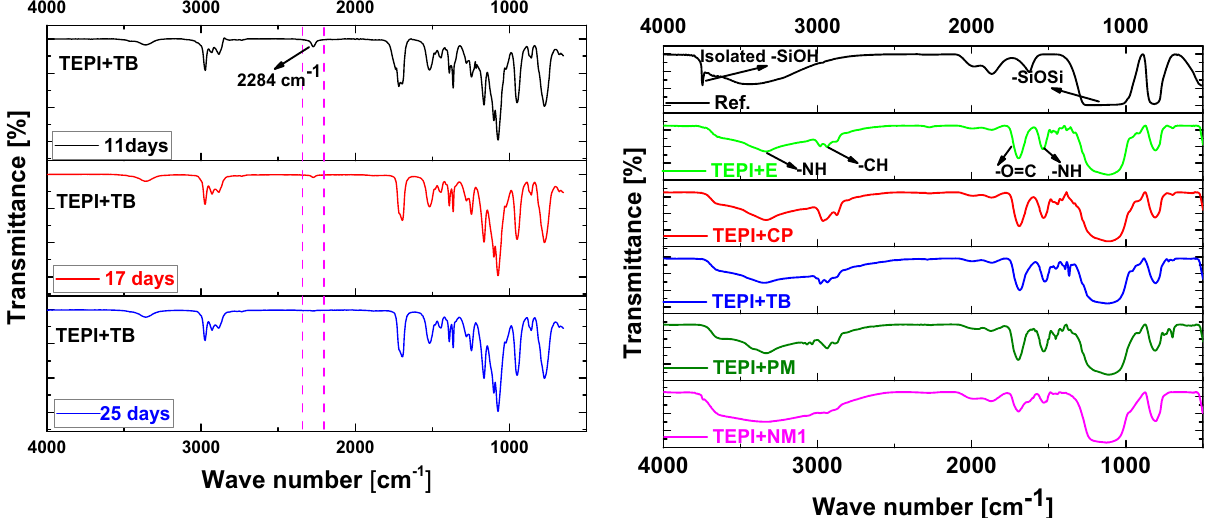
Figure 5: FTIR spectra of the mixture of TEPI and TB after 11, 17, and 25 days.